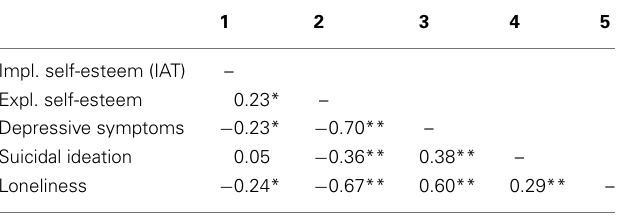
Table 2 | Correlations among measures of implicit and explicit self-esteem, depressive symptoms, suicidal ideation, and